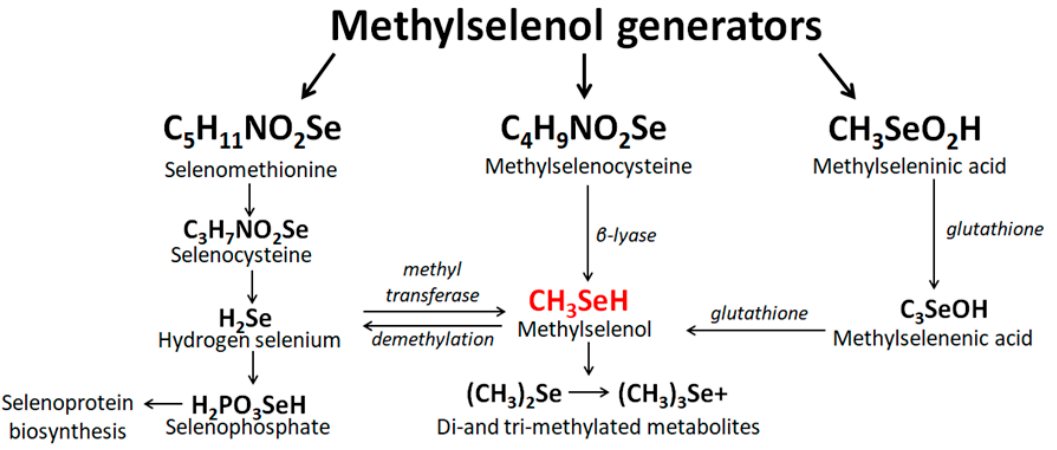
Figure 1. The conversion reactions of the most common methylselenol generators.